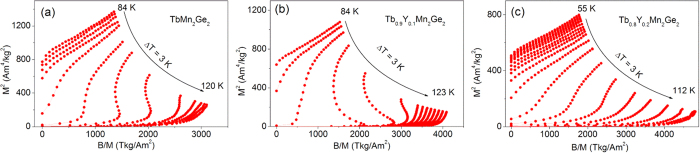
Arrott plots: isotherms graphs of M2 versus B/M for decreasing magnetic fields at temperatures around Tc.(a) TbMn2Ge2, (b) Tb0.9Y0.1Mn2Ge2 and (c) Tb0.8Y0.2Mn2Ge2.